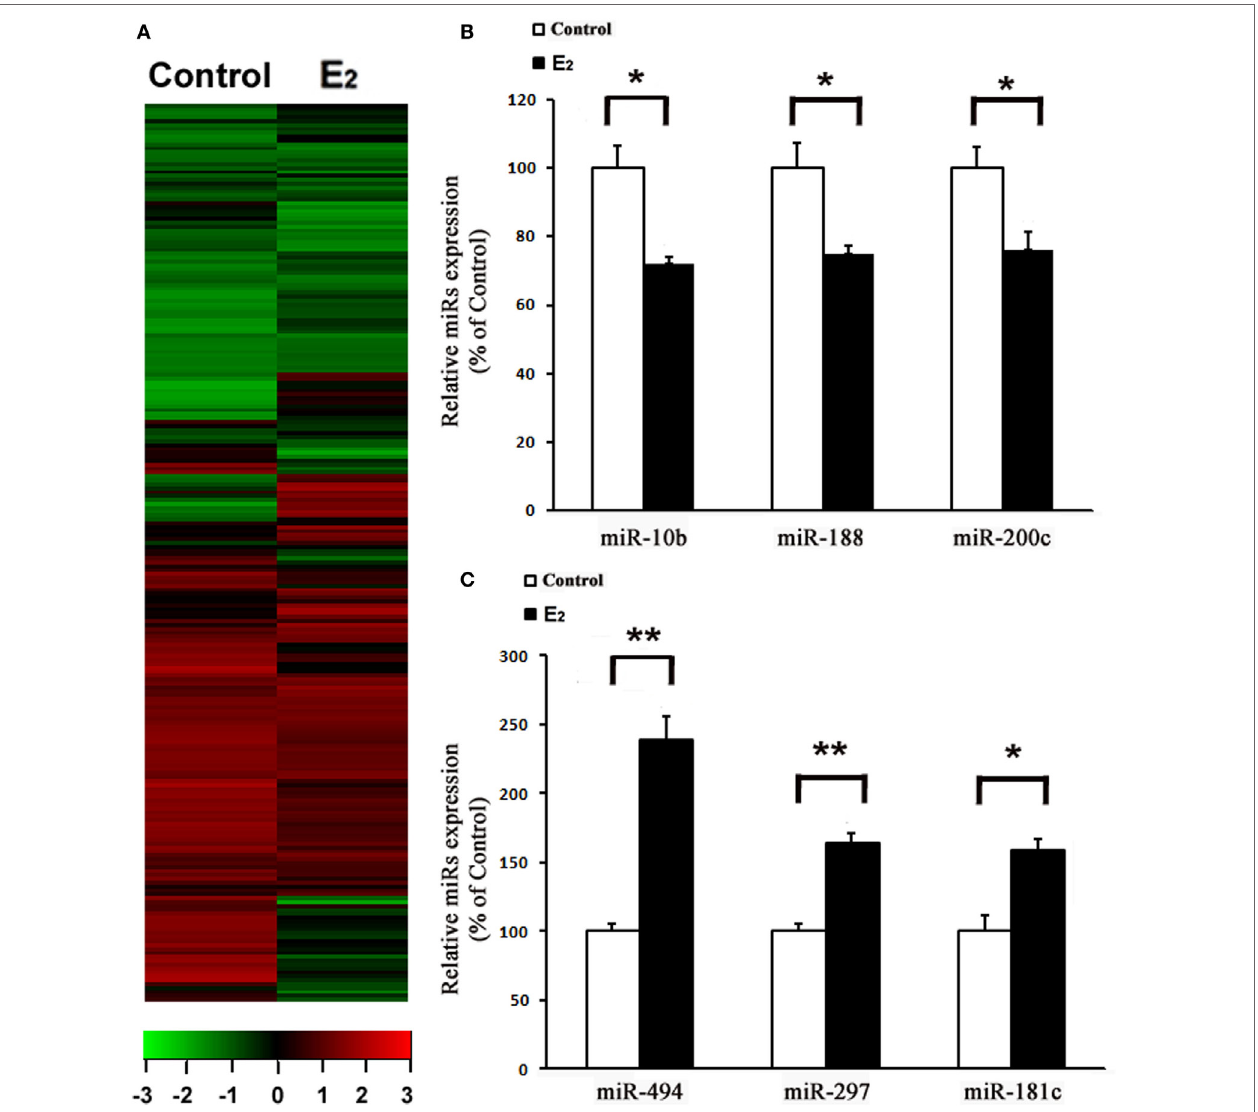
FigUre 1 | E 2 regulates microRNAs (miRs) expression in cardiomyocytes. (a) , Heatmap image of microarray data, illustrating differentially expressed miRs between the control and E 2 -treated cardiomyocytes ( n = 3). The scale is − 3 to + 3 in log10. Red indicates increased expression, and green indicates decreased expression. (B,c) Expressions of downregulated (B) and upregulated (c) miRs were determined by qRT-PCR by performing three independent experiments. All bar graphs represent the means ± SEM. * P < 0.05, ** P <